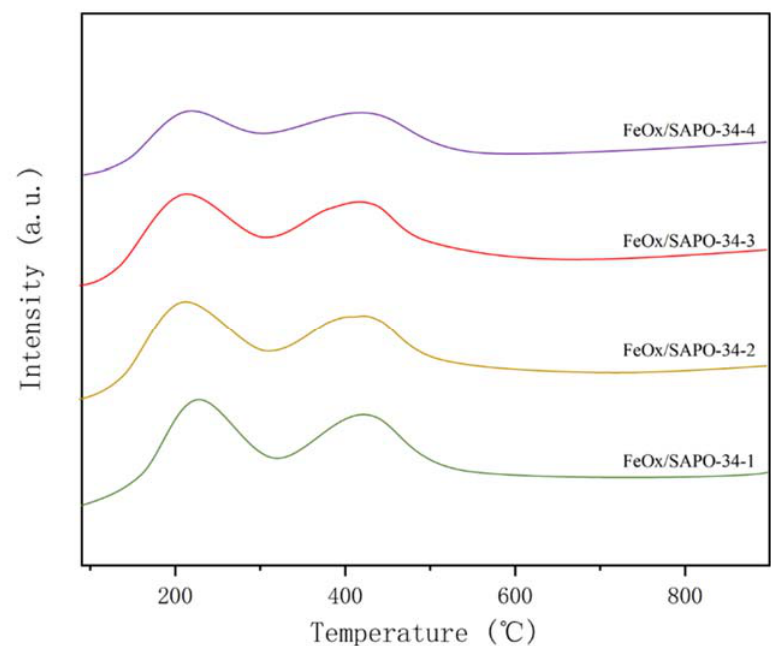
Figure 6. NH 3 -TPD spectrum of the FeO x /SAPO-34(x) molecular sieve samples prepared by the Figure 6. NH 3 ‐ TPD spectrum of the FeO x /SAPO ‐ 34(x) molecular sieve samples prepared by the im ‐ impregnation pregnation method.